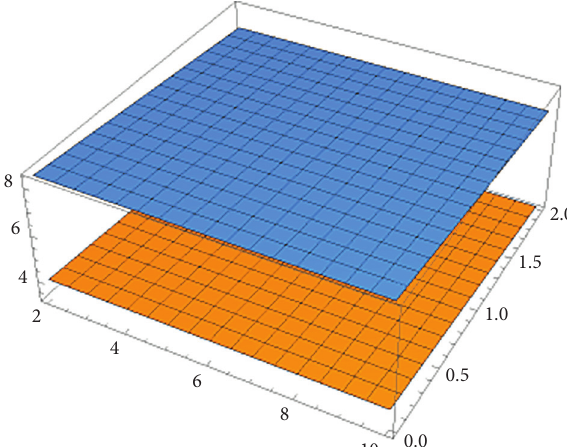
Figure 5: Dominance of the right-hand side of equation (34) is visually checked for τ , υ ∈ [ 0 , 2 ] .